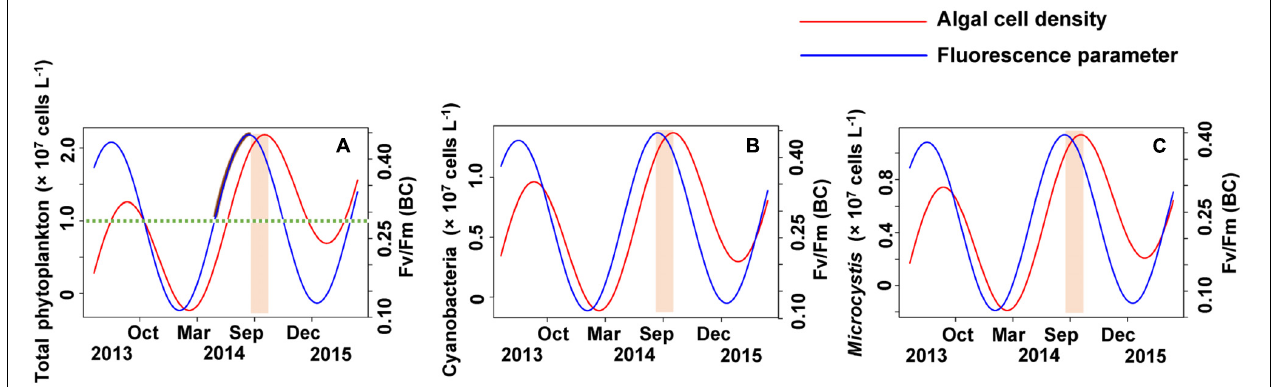
FIGURE 9 | The early warning of algal cell density and Microcystis bloom by simulating the time lag between F v / F m (BC) and algal cell density. (A) Total phytoplankton, (B) Cyanobacteria, (C) Microcystis .